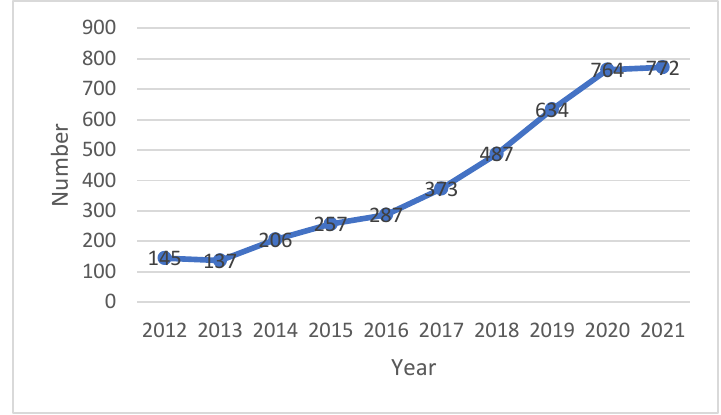
Figure 1. Distribution of literature quantity over time.